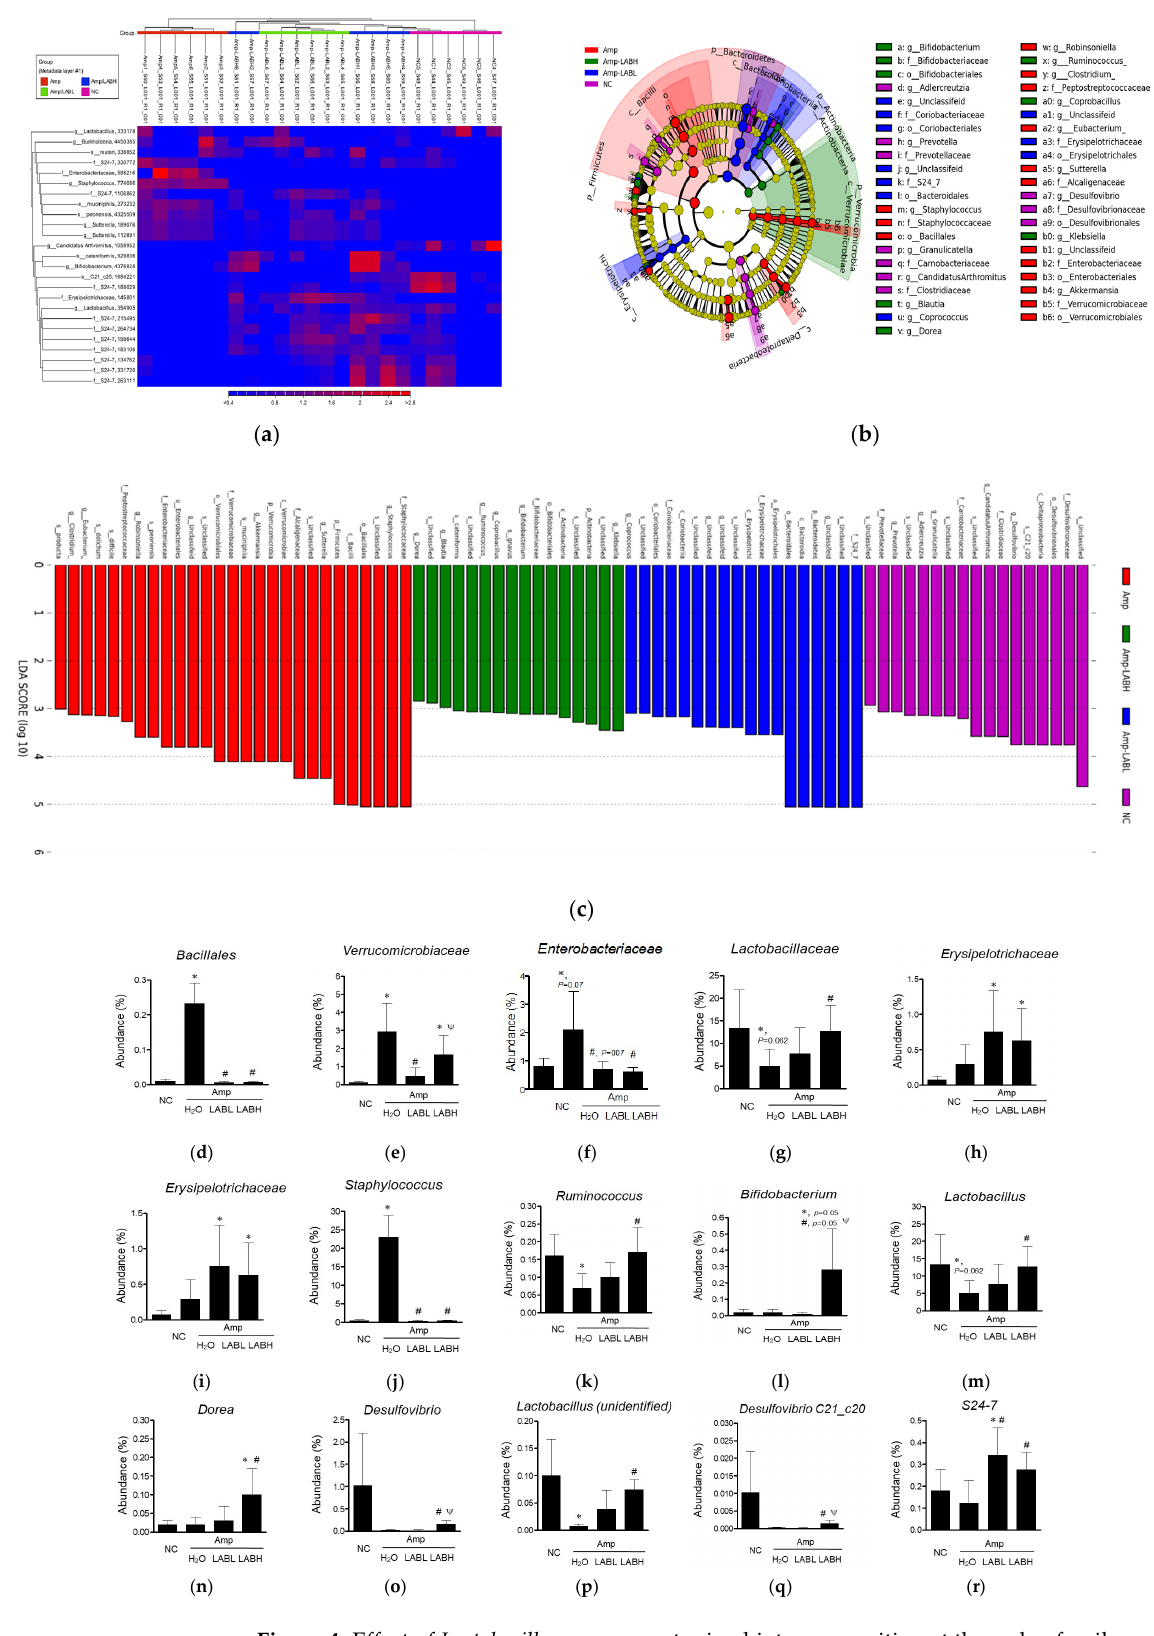
Figure 4. Effect of Lactobacillus spp. on gut microbiota composition at the order, family, genus, and species levels in C57BL/6J mice. C57BL/6J mice ( n = 6/group) were grouped into the normal control (NC) group and Amp group (Amp). The groups administered a composite formula with three strains were fed a dose of 1.6 × 10 8 CFU/mouse (low dosage, LABL) or 4.8 × 10 8 CFU/mouse (high dosage, LABH) from the 3rd day until the 7th day. All groups were analyzed for 16S ribosomal RNA V3 − V4 gene expression in the ileum on the 12th day. ( a ) OTU heatmap distribution, ( b ) Principal coordinate analysis of Bray–Curtis dissimilarity, ( c ) the microbial community relative LDA score. Order level: ( d ) Bacillales spp.; Family levels − ( e ) Verrucomicrobiaceae spp., ( f ) Enterobacteriaceae spp., ( g ) Lactobacillaceae spp., ( h ) Erysipelotrichaceae spp.; genus level: ( i ) Prevotelia spp., ( j ) Staphylo- coccus spp., ( k ) Ruminococcus spp., ( l ) Bifidobacterium spp., ( m ) Lactobacillus spp., ( n ) Dorae spp., ( o ) Desulfovibrio spp.; species levels: ( p ) Lactobacillus (unidentified) spp., ( q ) Desulfovibrio C21_c20 spp., ( r ) S24 − 7 spp. *, compared with NC group, p < 0.05; #, compared with Amp group, p < 0.05; Ψ com- pared with LABL group, p < 0.05. The Amp group had significantly higher Staphylococcus abundance and lower Rumi- nococcus abundance than the NC groups ( p < 0.05) (Figure 4j,k). In contrast, the Staphylo- coccus abundance in the LABL and LABH groups was significantly lower than that in the Amp group ( p < 0.05), and the Ruminococcus abundance was significantly higher in the LABH group than in the Amp group ( p < 0.05) (Figure 4j,k). In addition, the LABH group had a significantly higher abundance of Ruminococcus , Bifidobacterium , Lactobacillus , Dorea, and Desulfovibrio than the Amp group ( p < 0.05) (Figure 4k–o). At the species level, Amp treatment significantly decreased Lactobacillus (unidentified) abundance ( p < 0.05) (Figure 4p). In addition, the abundance of Lactobacillus (unidentified) and Desulfovibrio C21 − c20 was significantly higher in the LABH group than in the Amp group ( p < 0.05) (Figure 4p, r). Both the LABL and LABH groups showed significantly higher S24 − 7 abundance than the Amp group ( p < 0.05) (Figure 4r).